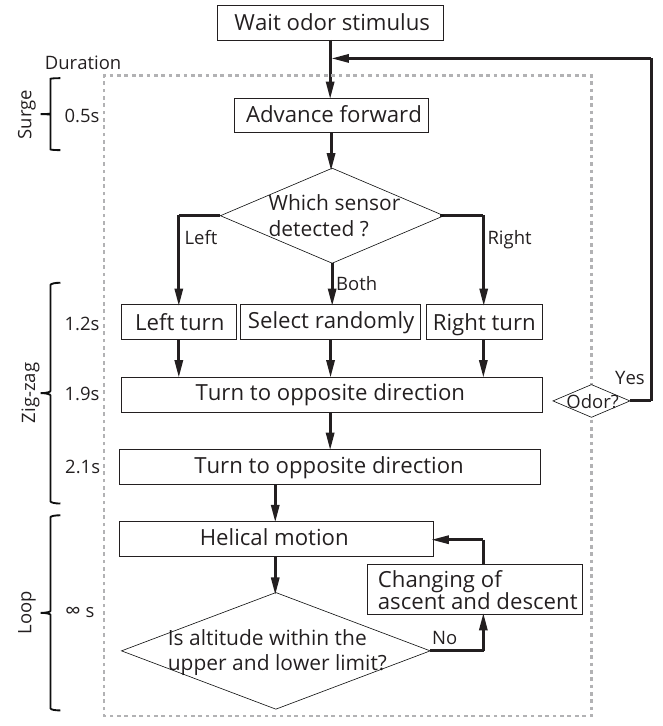
Figure 6. The flowchart of the three-dimensional silkworm-moth-inspired CPT